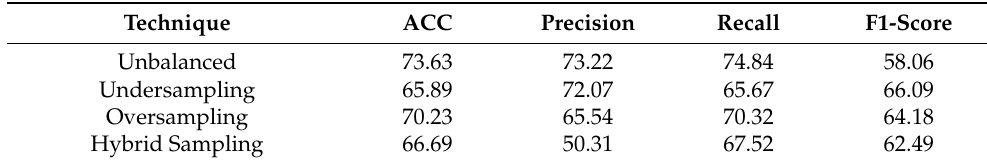
Table 14. Evaluation metrics for the CICIDS2017 dataset with hybrid sampling. Table 15. Overall results for the Morris power dataset.